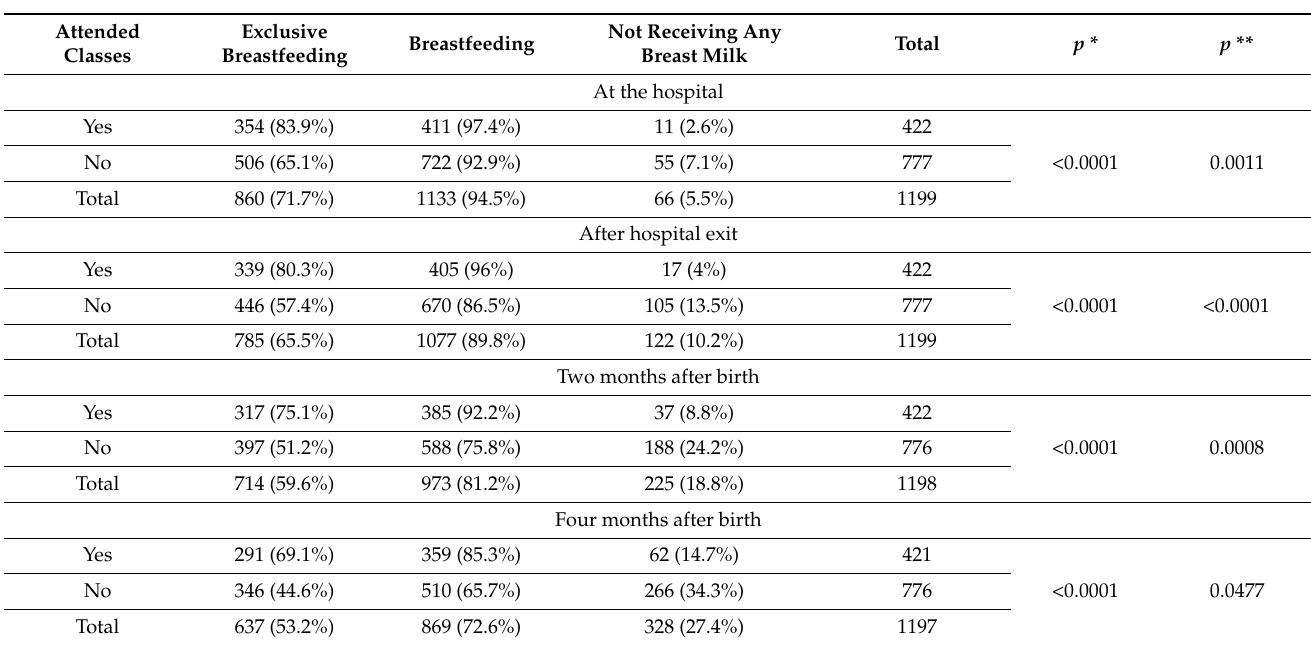
Table 6. The relationship between the attendance of antenatal breastfeeding classes and the rates of the exclusive breastfeeding, the breastfeeding and the infants who did not receive any breast milk by infants’